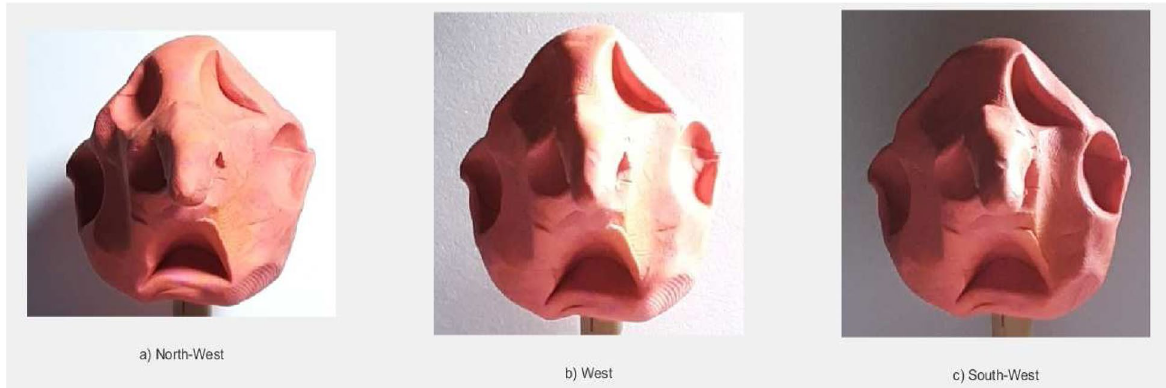
Fig. 4 Images captured using the experimental setup (Fig. 3), for three different table lamp positions (north-west, west and